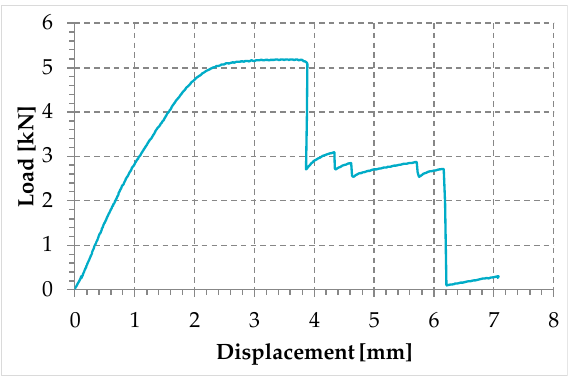
Figure 19. Positioning the LVDT (Linear Variable Differential Transformer) to measure the displacement of the crosshead.